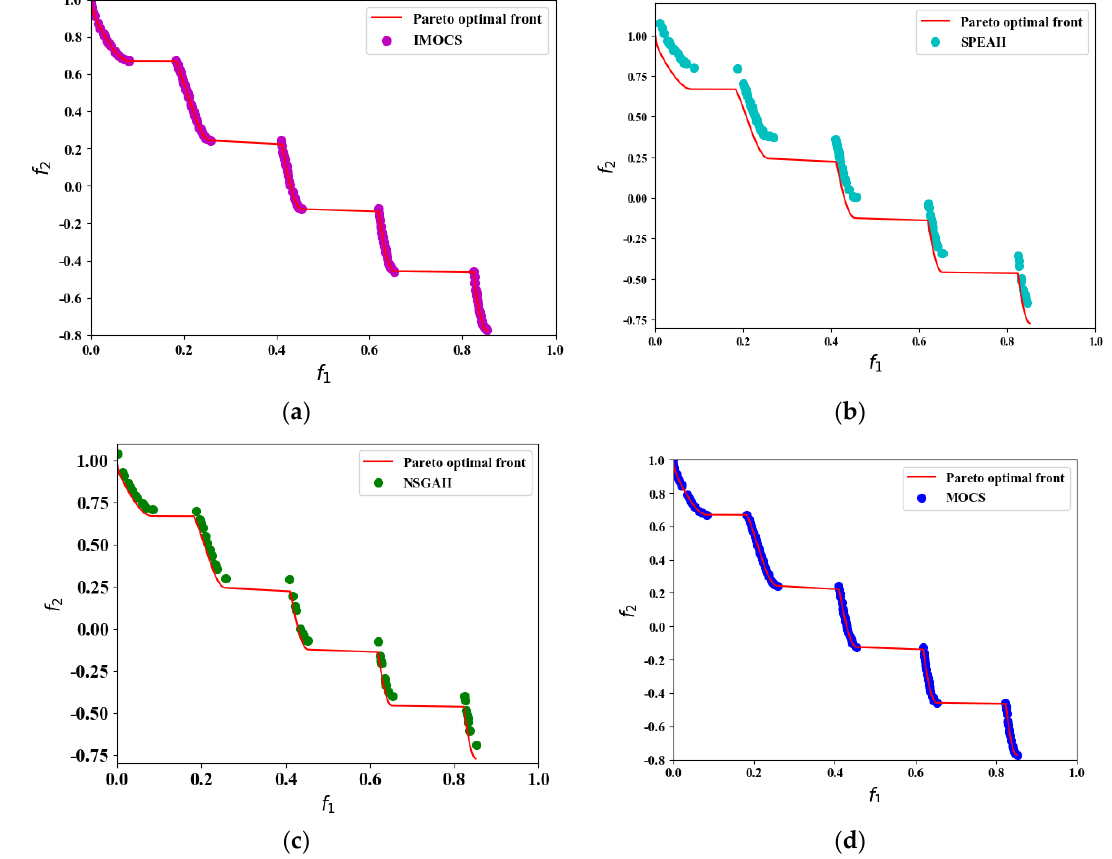
Figure 4. The convergence results of ZDT3 test problem over all algorithms. ( a ) IMOCS, ( b ) SPEAII, ( c ) NSGAII, and ( d ) MOCS.